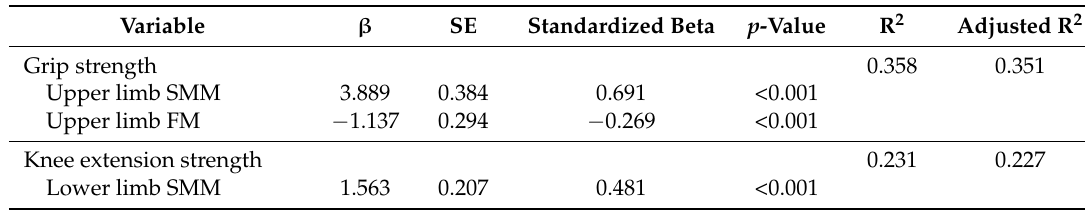
Table 2. Stepwise multiple regression